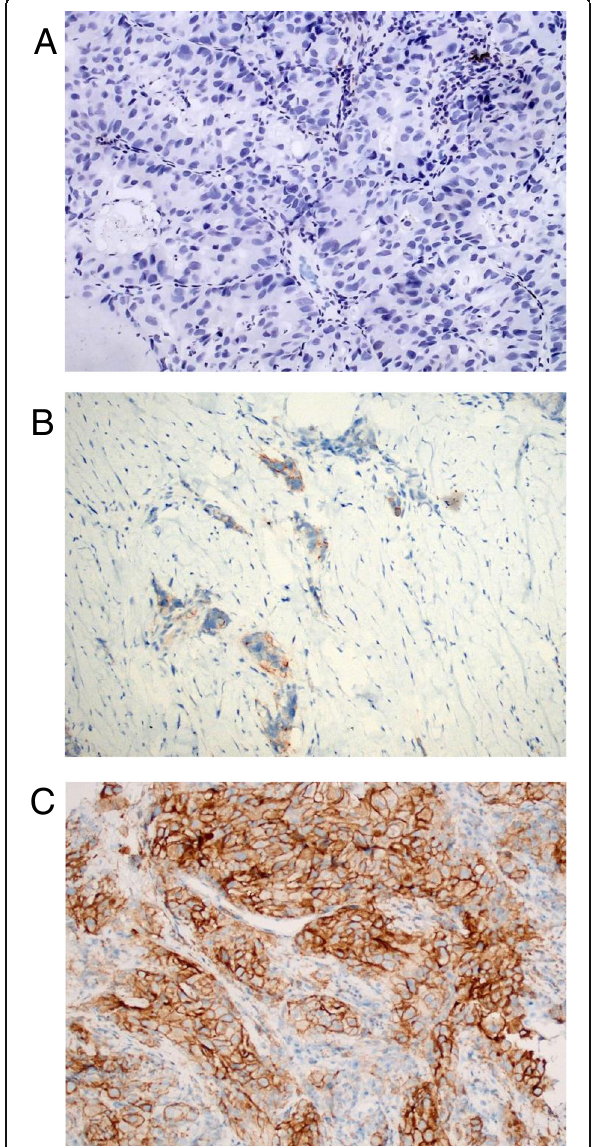
Fig. 1 Representative figures of immunohistochemical staining for PD- L1 in resected tumors from patients with primary lung adenocarcinoma (400x magnification). ( a ) PD-L1 TPS<1%. ( b ) PD-L1 TPS 2%. (C) PD-L1 TPS ≥ 50%. PD-L1: programmed cell death-ligand 1, TPS: tumor proportion score